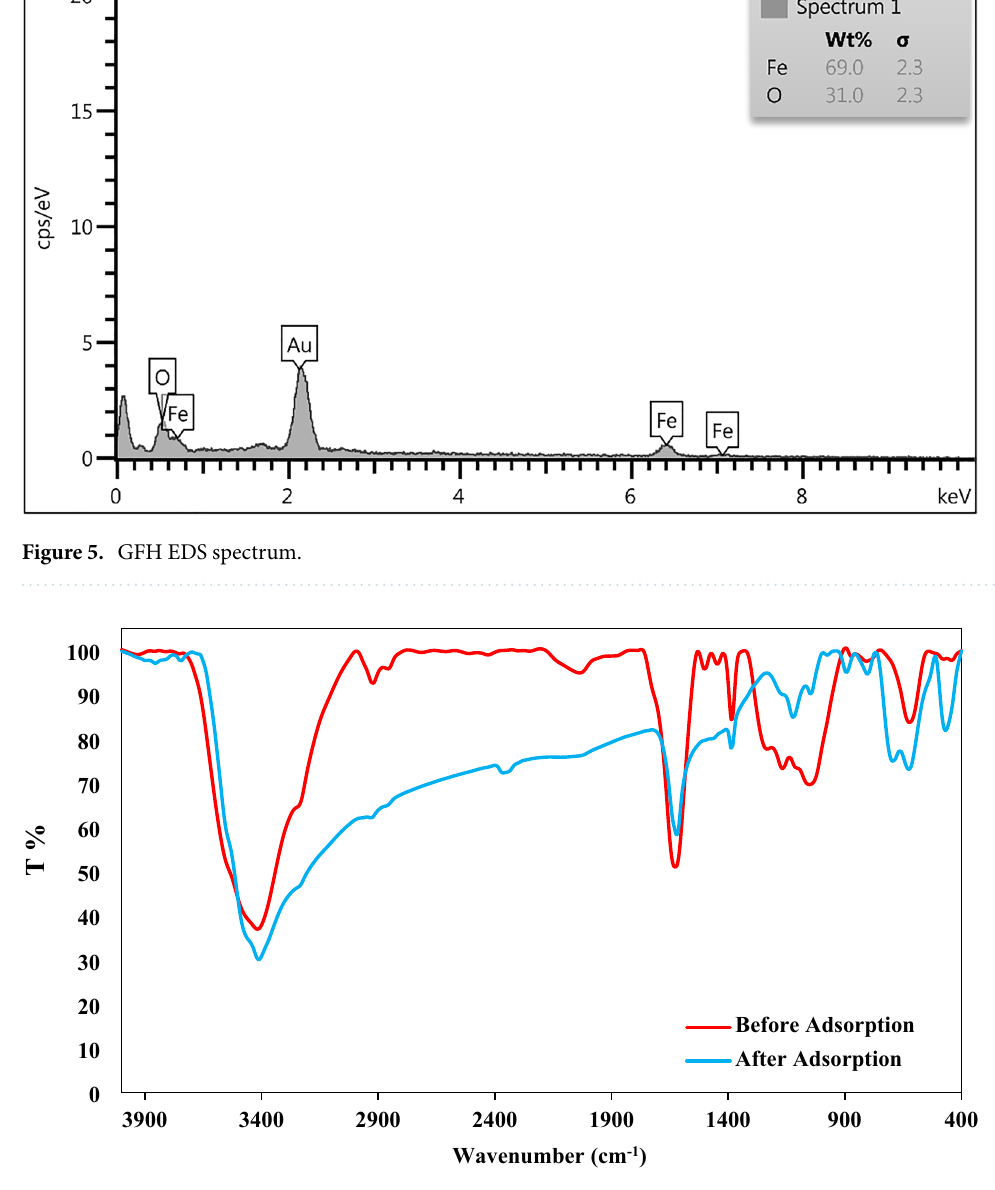
Figure 6. AR18 FTIR before and after of adsorption.